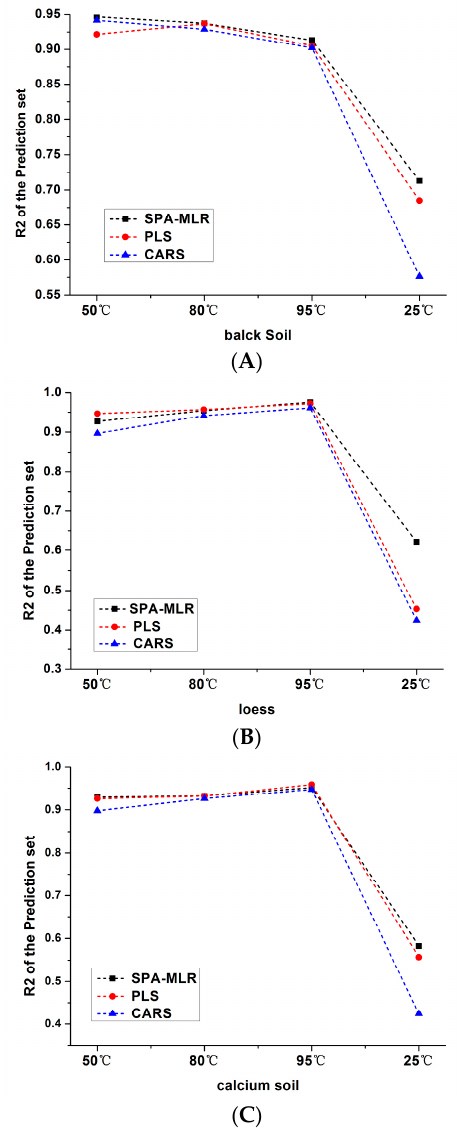
Figure 9. Prediction results of three kinds of soil based on different temperatures algorithms: ( A ) black soil; ( B ) loess; ( C ) calcium soil.